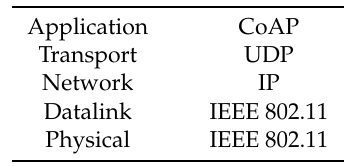
Table 3. IoT-oriented protocol stack adopted inside the greenhouse module (right) with corresponding reference ISO/OSI layers (left).